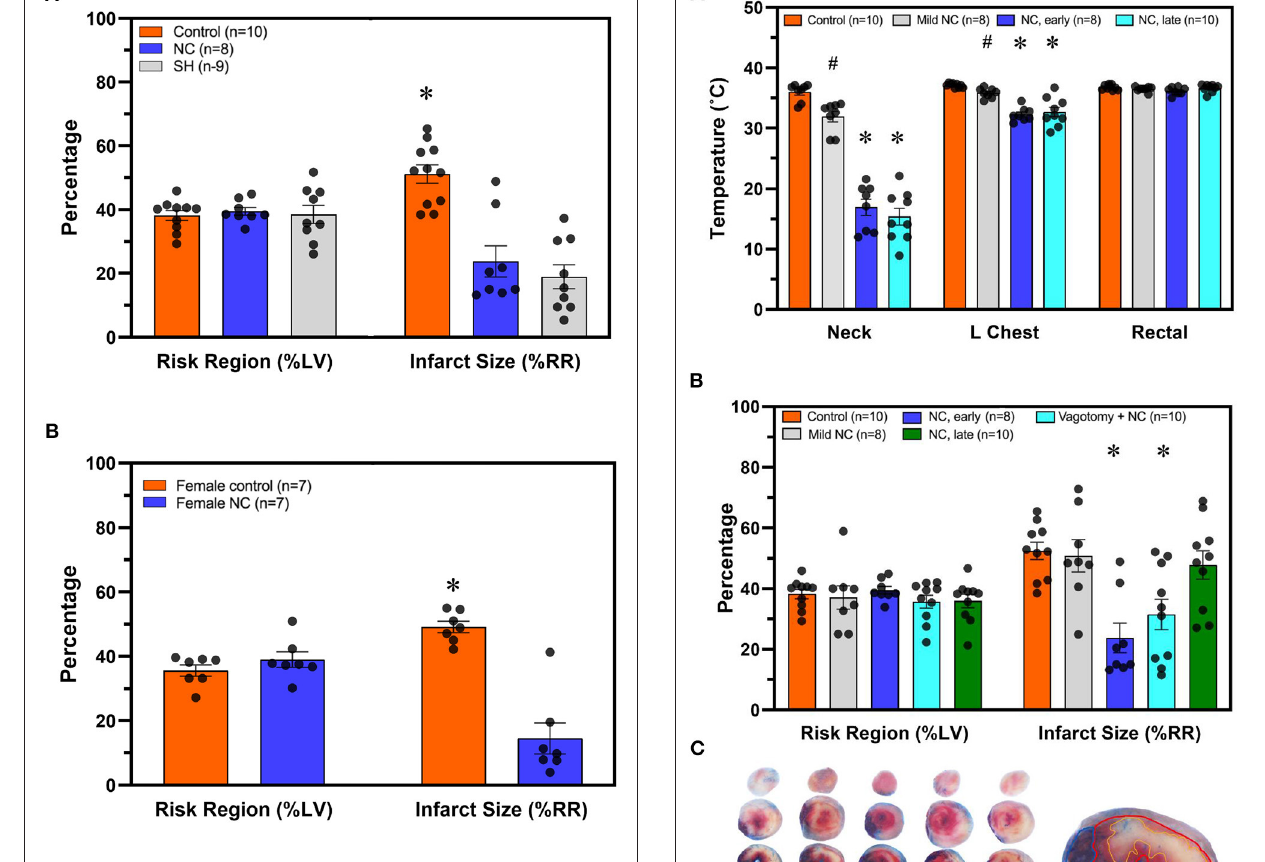
FIGURE 2 | Topical neck cooling exerts a comparable infarct-sparing effect to systemic hypothermia. (A) Risk region and infarct size were calculated in male mice that underwent systemic hypothermia or topical neck cooling and compared to control mice following myocardial ischemia-reperfusion injury. (B) Similar results of infarct-sparing with topical neck cooling compared to control were observed in female mice as compared to male mice following myocardial ischemia-reperfusion injury. RR, risk region; LV, left ventricle; NC, topical neck cooling; SH, systemic hypothermia; * p < 0.05 vs. other groups.